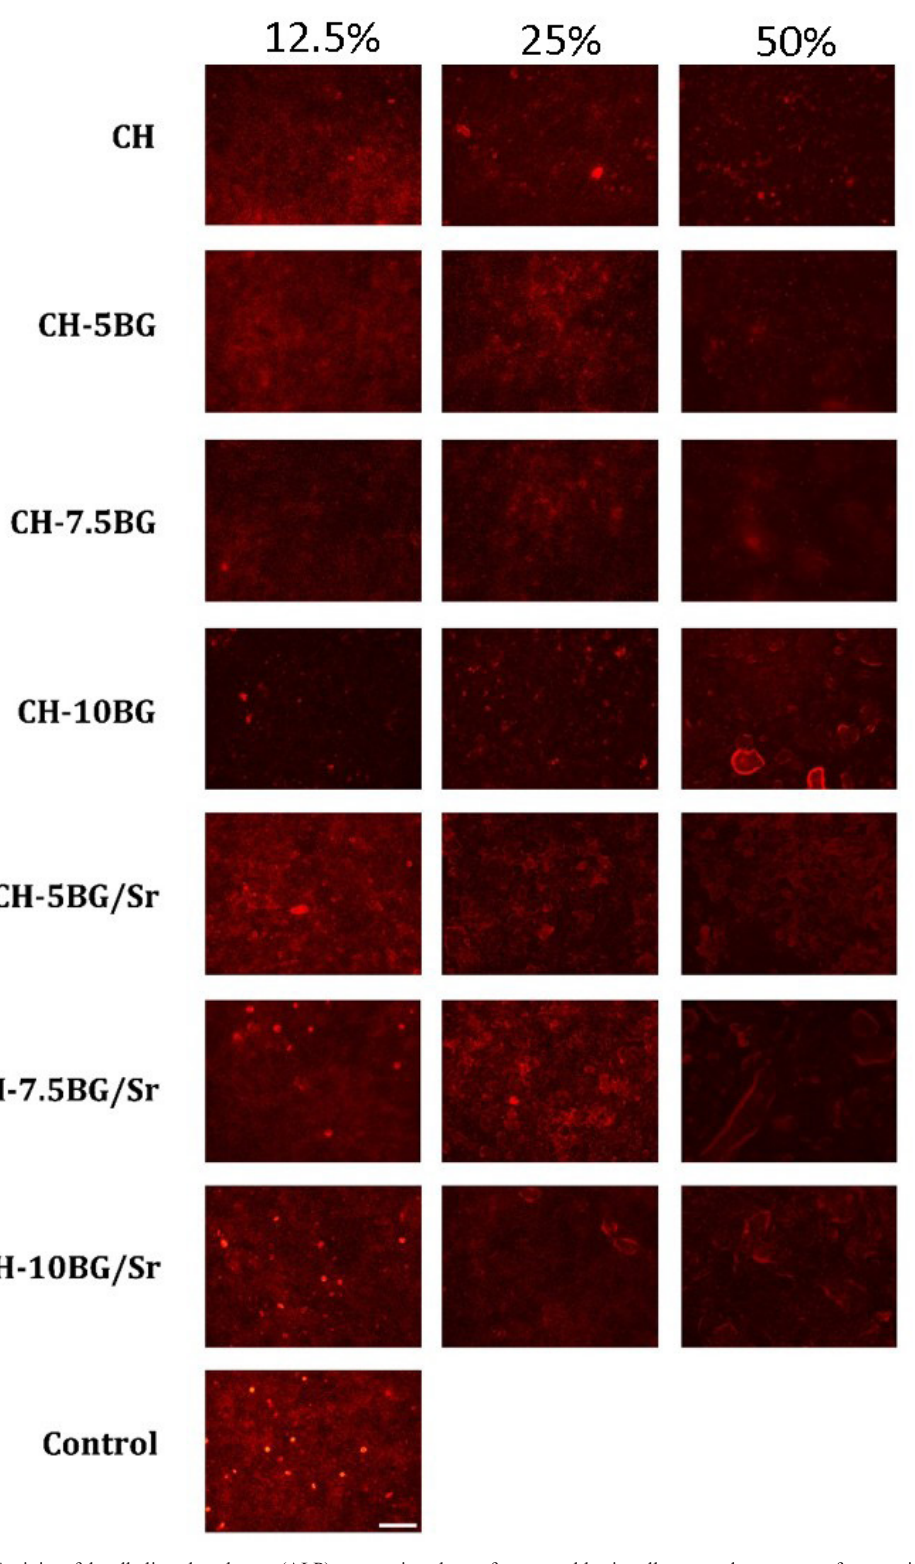
Figure 9. Activity of the alkaline phosphatase (ALP) enzyme in culture of pre-osteoblastic cells exposed to extracts of compositions based on calcium aluminate cement (CH) containing different contents of bioactive glass (BG) and strontium (Sr) in concentrations of 12.5%, 25% and 50% or in their absence (control) for 7 days. Scale bar = 200